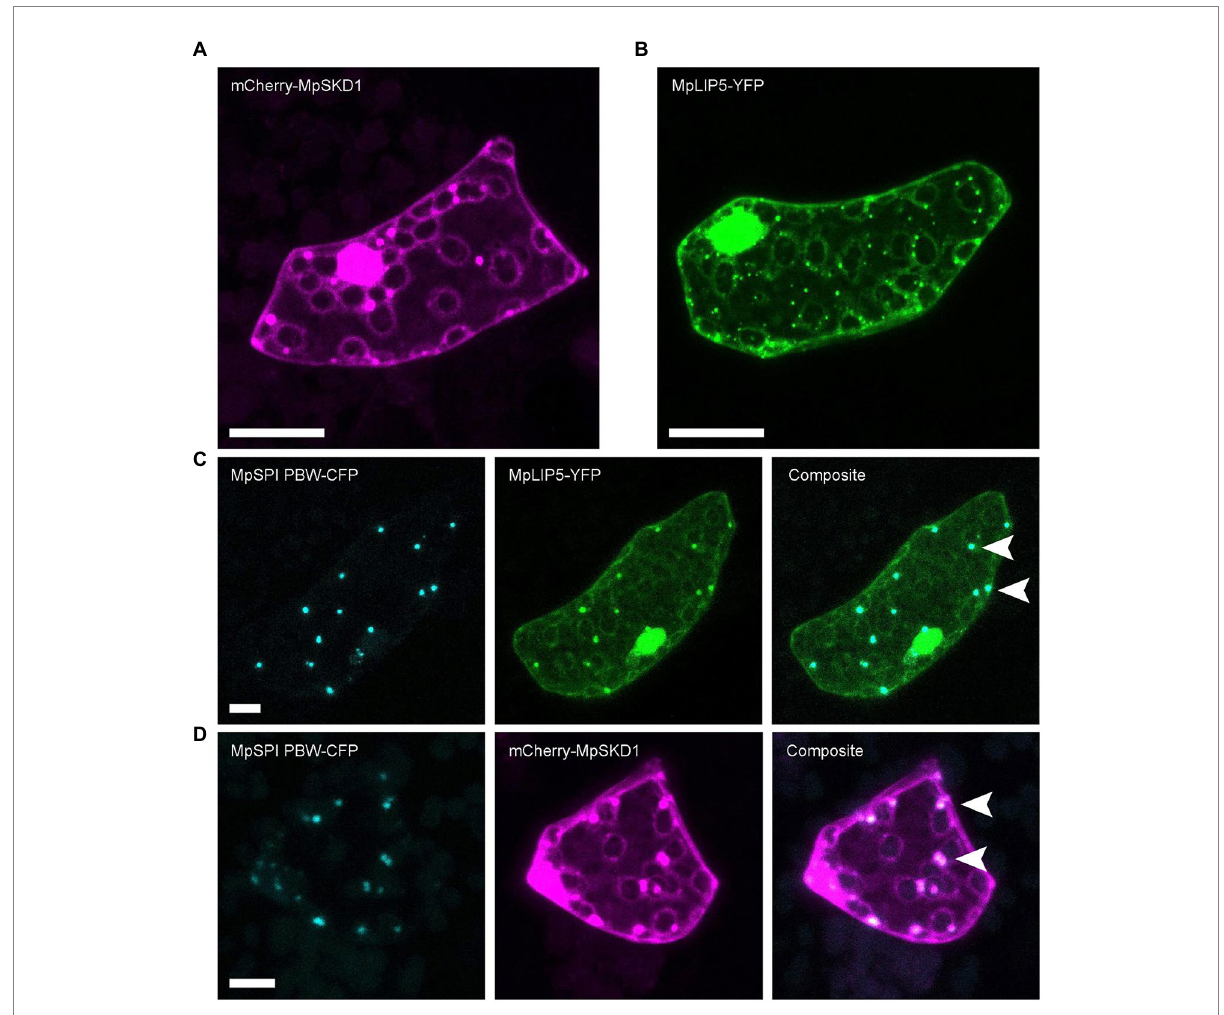
FIGURE 5 MpSPI PBW co-localizes with ESCRT components in M. polymorpha. (A) Dot-like localization of transiently expressed mCherry-MpSKD1 in Tak-1 epidermal cells. (B) Dot-like localization of transiently expressed MPLIP5-YFP in Tak-1 epidermal cells. (C) Transient co-expression of MpSPI PBW and MpLIP5-YFP in Tak-1 epidermal cells. (D) Transient co-expression of MpSPI PBW and MpSKD1 in Tak-1 epidermal cells. Arrowheads indicate areas of co-localization. Scale bars = 20 μ